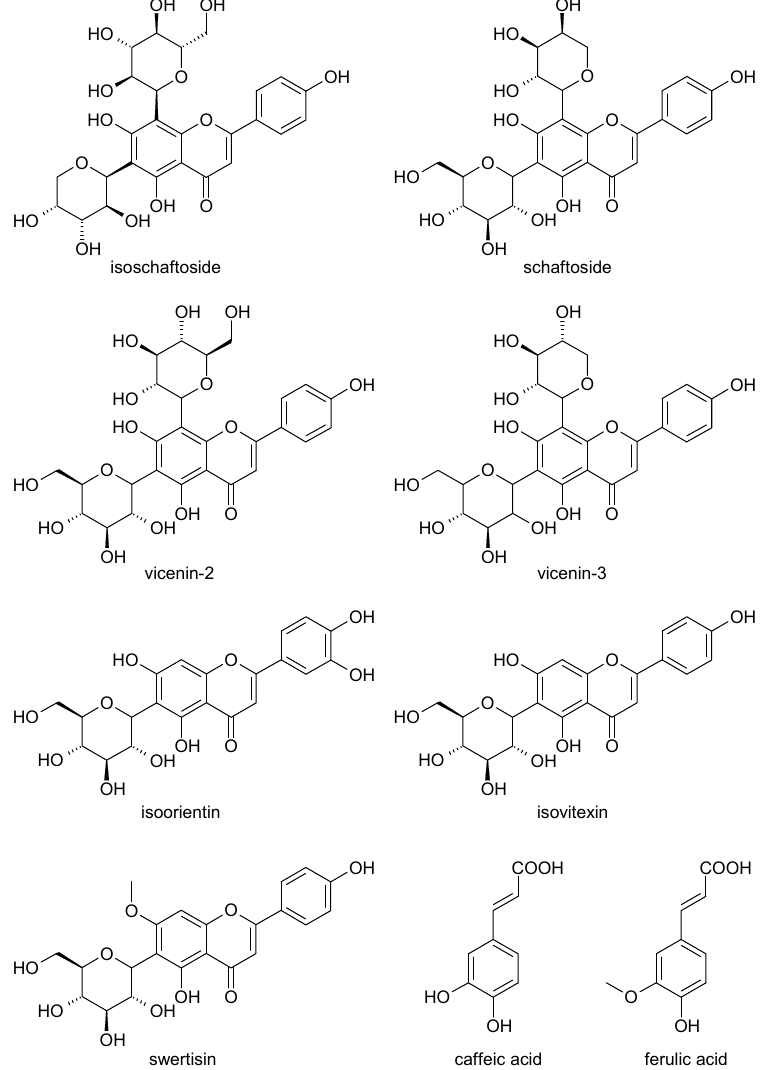
Figure 5. The structures of the compounds identified tentatively in A. wilhelmsii.